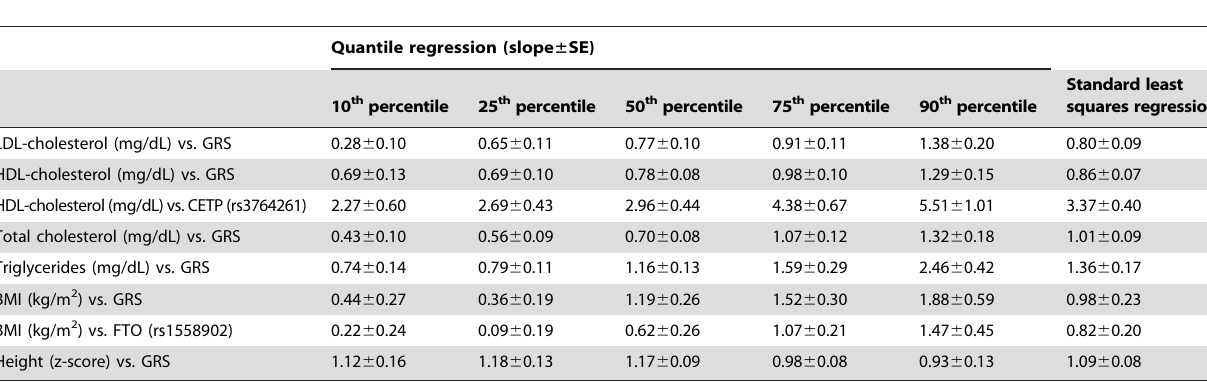
Table 1. Standard least-squares and quantile regression analyses of lipids, lipoproteins, BMI and height.